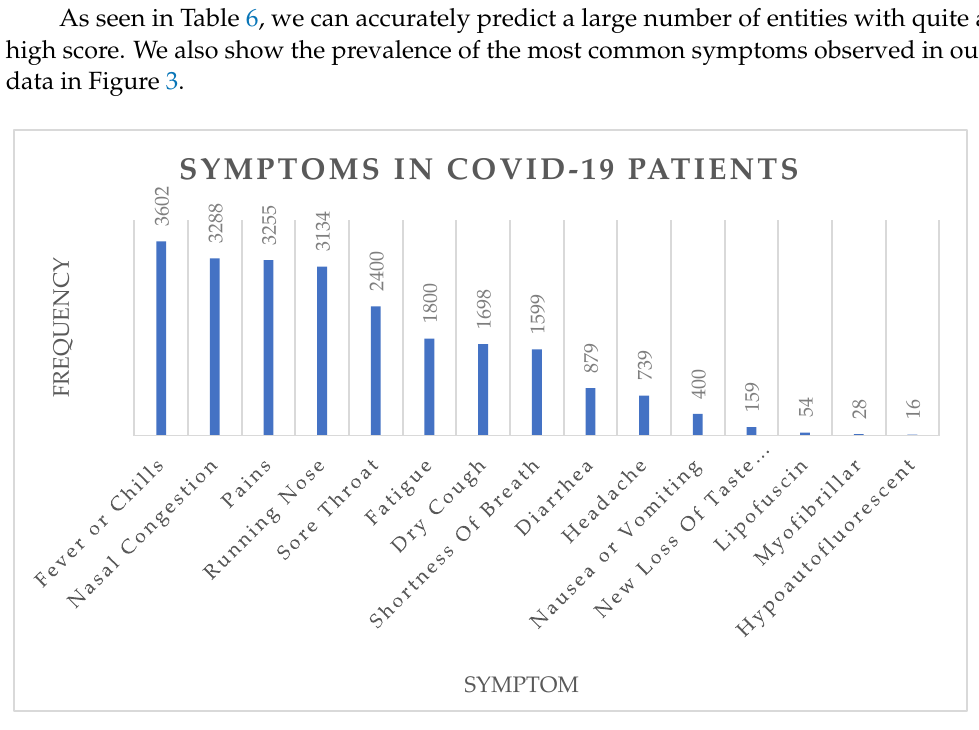
Figure 3. Most common symptoms of COVID-19 patients. Number at the top of each bar represents the number of times the symptoms were mentioned in test set.